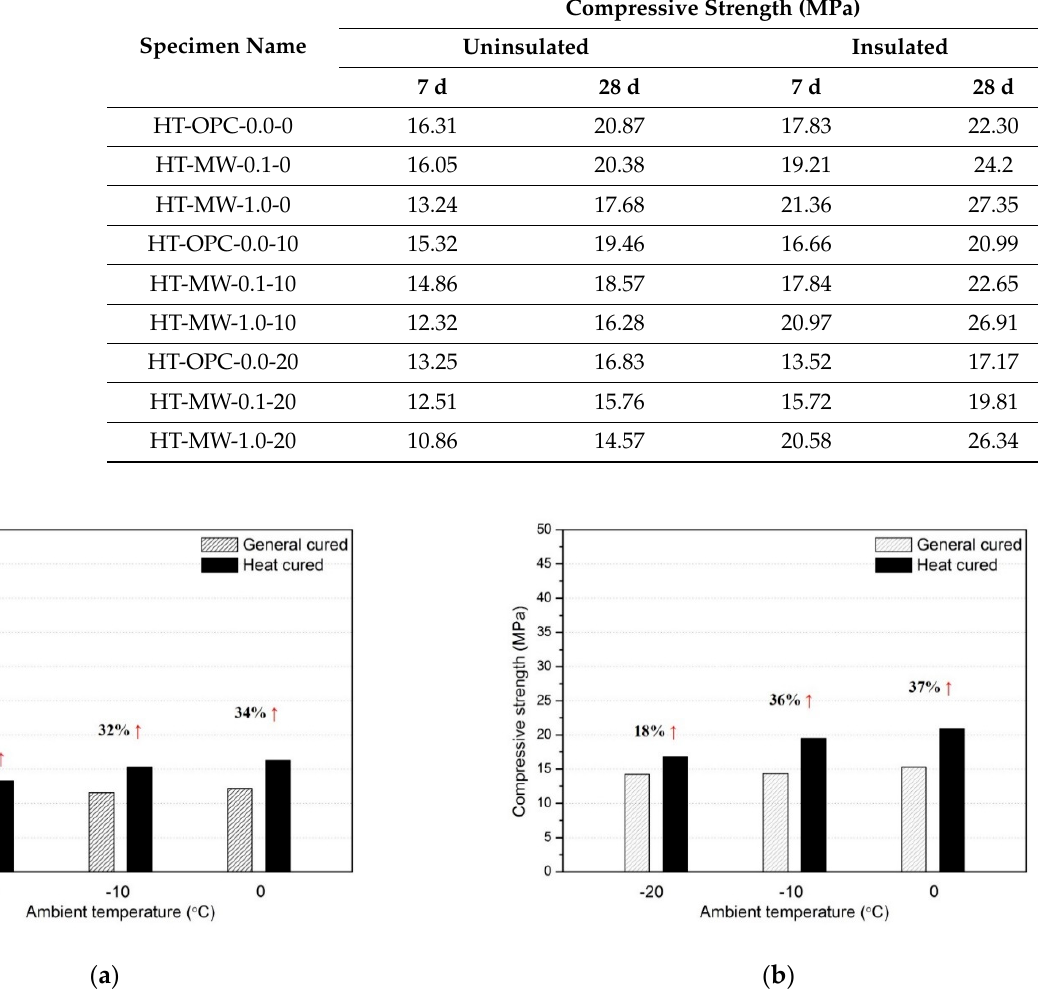
Figure 8. Compressive strength of the OPC specimens after ( a ) 7 days and ( b ) 28 days. Table 3. Compressive strength of the specimens.